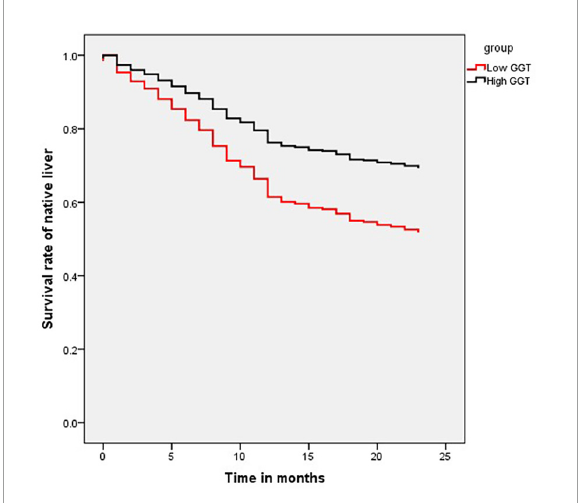
FIGURE2 Kaplan–Meier curve showing native liver survival of low- and high-GGT